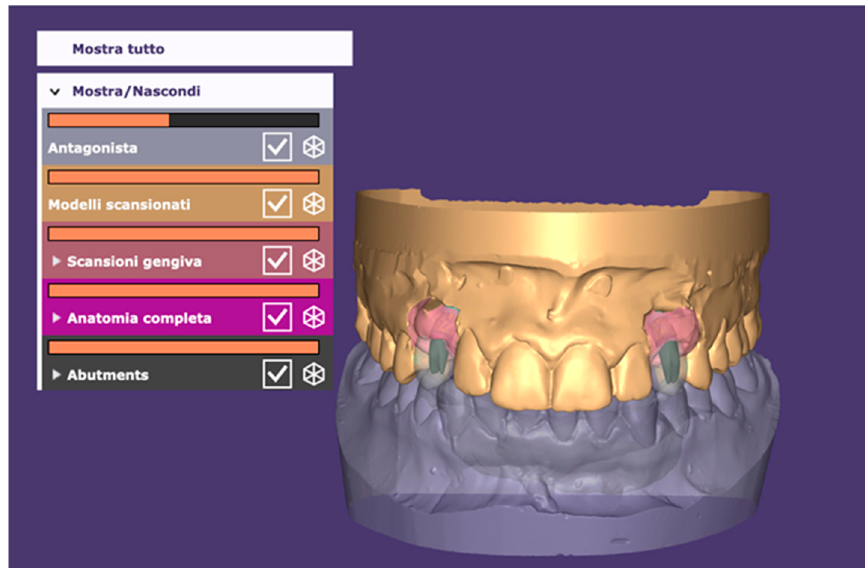
Figure 6. CAD-CAM